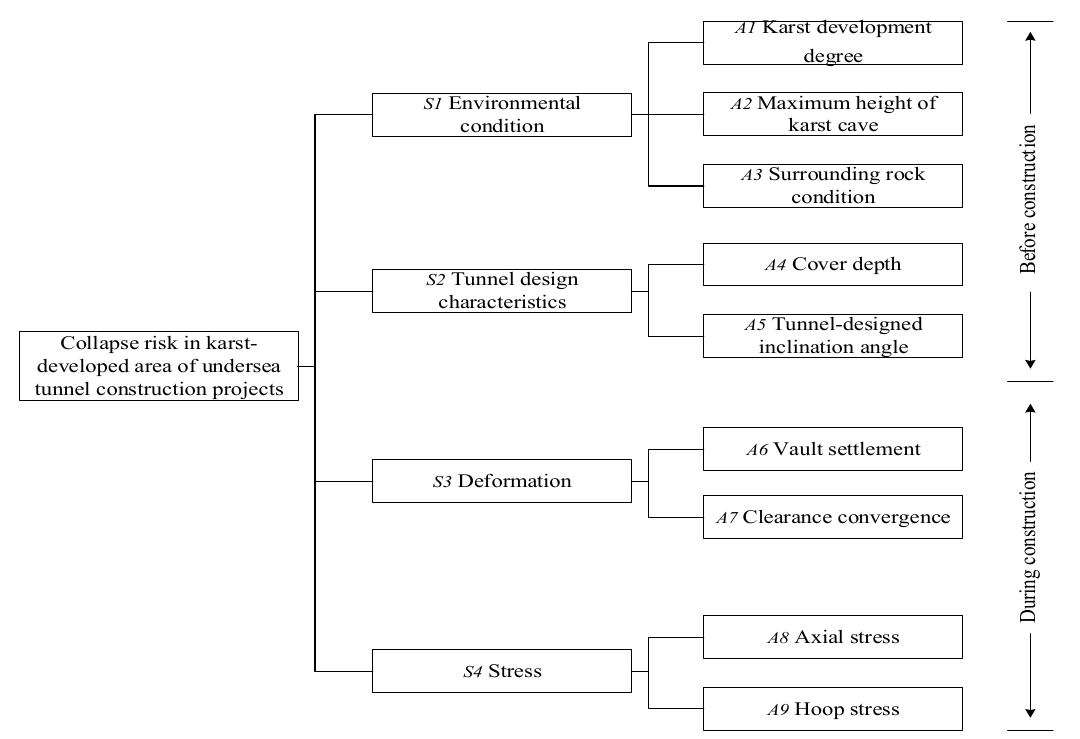
Figure 2. The tunnel collapse risk evaluation index system in the karst developed area.